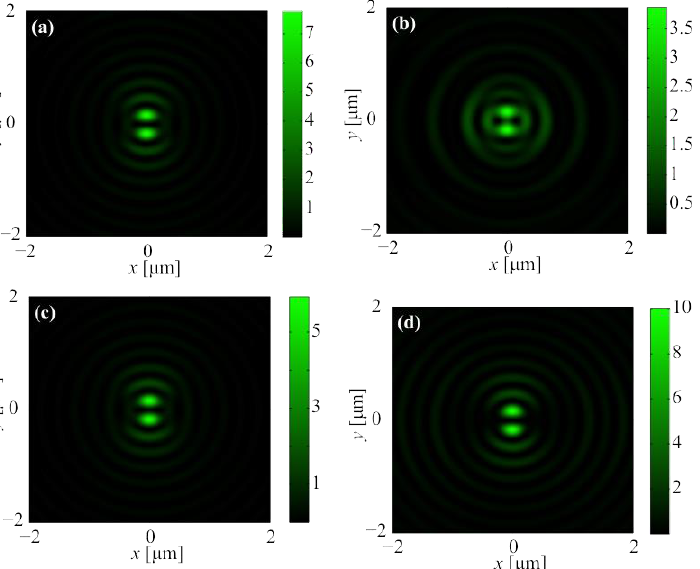
Figure 6. The instantaneous pattern of the intensity of the second-order CVB in the focus of the BZP with relief from: aluminum with height of 50 nm ( a ), gold with height of 140 nm ( b ), chrome with height of 70 nm ( c ), and quartz with height of 532 nm ( d ).